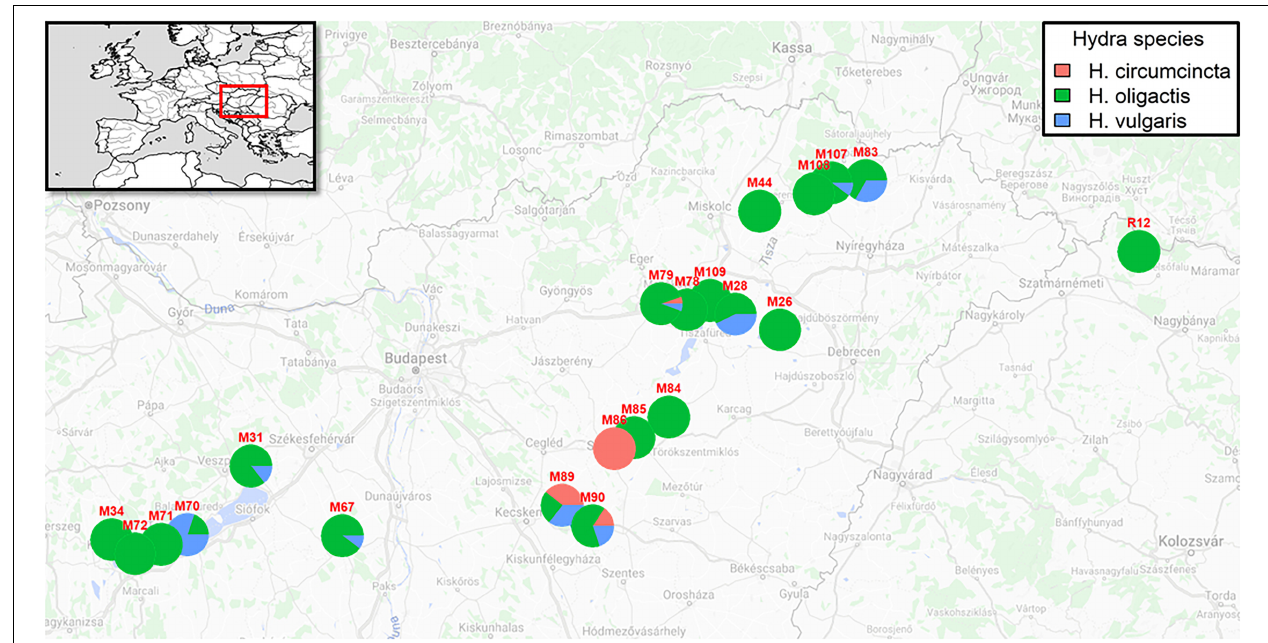
FIGURE 1 | Map showing sampling locations and proportion of Hydra species. The inset shows the geographic location of the sampling area in the Europe map. The pie charts represent the proportion of species detected in each water